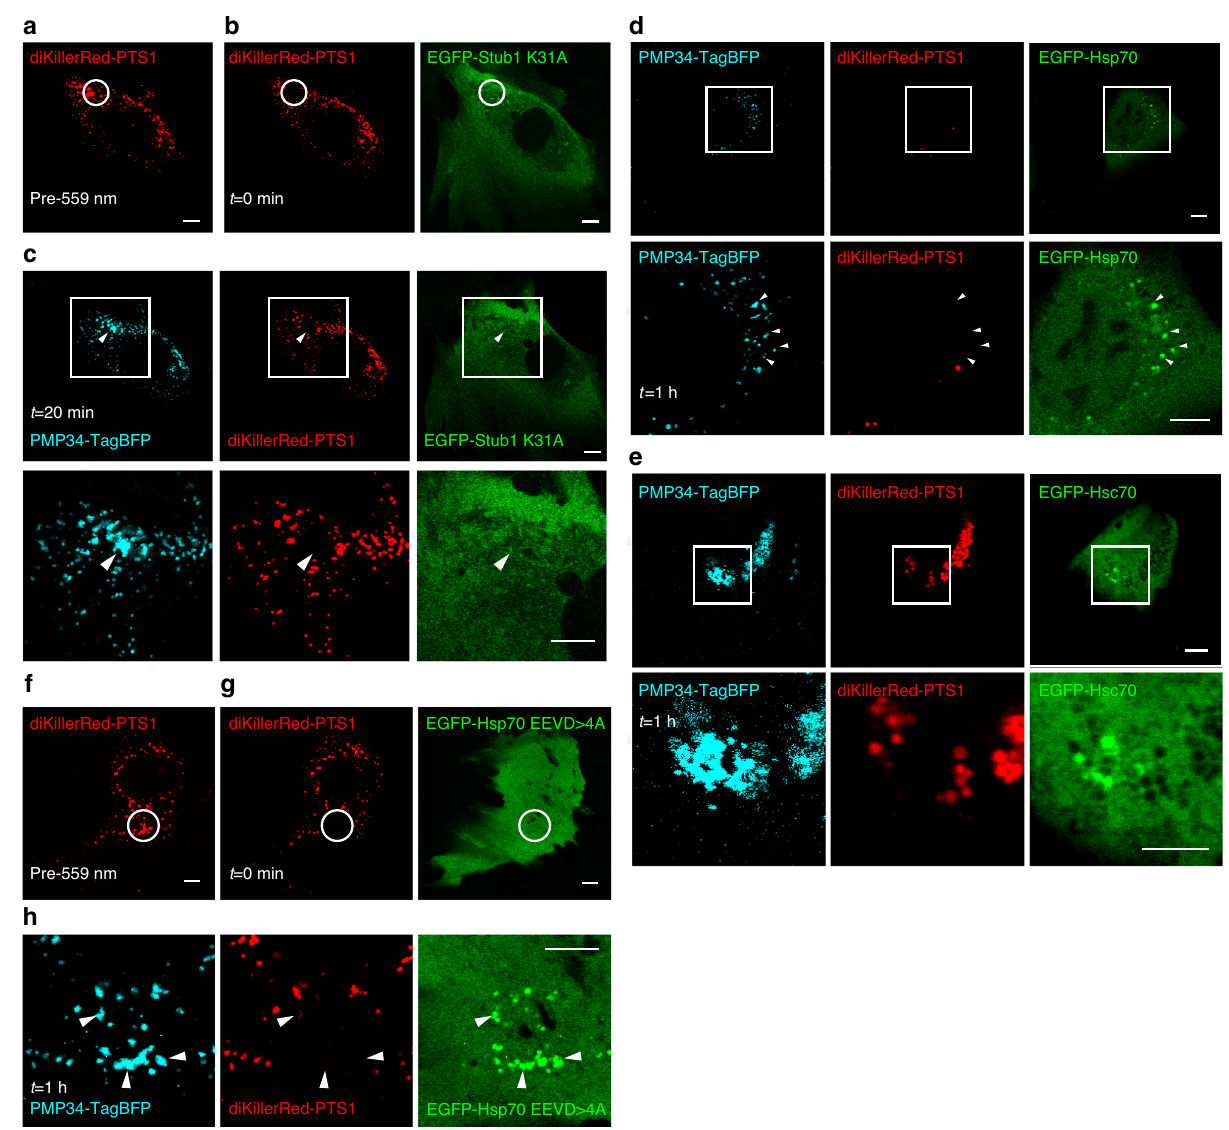
Fig. 5 Hsc70/Hsp70 mediates Stub1 translocation onto ROS-stressed peroxisomes. A NIH3T3 cell expressing diKillerRed-PTS1, PMP34-TagBFP, and EGFP-Stub1 K31A was 559 nm illuminated in the white circular region ( a ), leading to the immediate loss in diKillerRed-PTS1 fl uorescence ( b ). EGFP-Stub1 K31A did not accumulate on the ROS-stressed peroxisomes ( c , top row, white arrowheads; bottom row: magni fi ed view of the white square region in the top row, n = 4 cells). d Peroxisomes in a NIH3T3 cell expressing diKillerRed-PTS1, PMP34-TagBFP, and EGFP-Hsp70 were ROS stressed through 559 nm light illumination. Later EGFP-Hsp70 accumulated on ROS-stressed peroxisomes (white arrowheads; bottom panels represent magni fi ed views of the white square region in top panels; 1 h after illumination shown, n = 12 cells). e As in d , but with EGFP-Hsc70 expression. Hsc70 similarly accumulated on ROS- stressed peroxisomes (bottom panels represent magni fi ed views of the top panels; 1 h after illumination shown; n = 7 cells). f A NIH3T3 cell expressing diKillerRed-PTS1, PMP34-TagBFP, and EGFP-Hsp70 EEVD > 4 A was 559 nm illuminated in the white circular region, leading to the immediate loss in diKillerRed-PTS1 fl uorescence ( g ). h Later EGFP-Hsp70 EEVD> 4 A accumulated on ROS-stressed peroxisomes (white arrowheads; 1 h after illumination shown; n = 4 cells). All scale bars: 5 μ